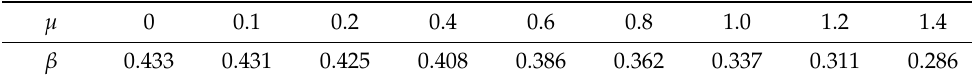
Table 1. Calculated β given by Equation (3) using µ in Equation